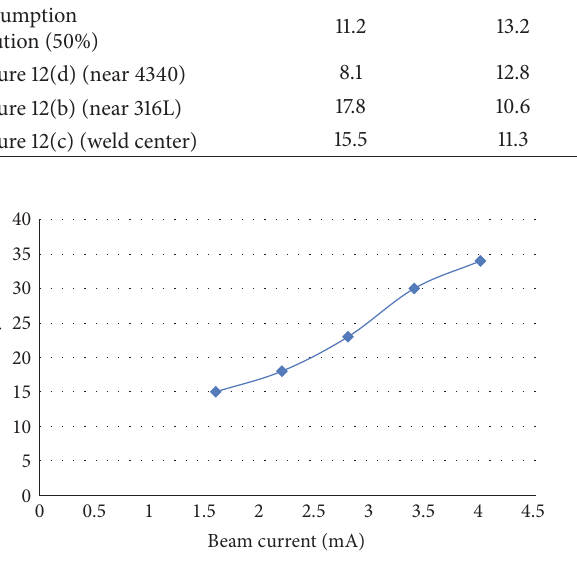
Figure 6: The effect of beam current on weld zone grain size.